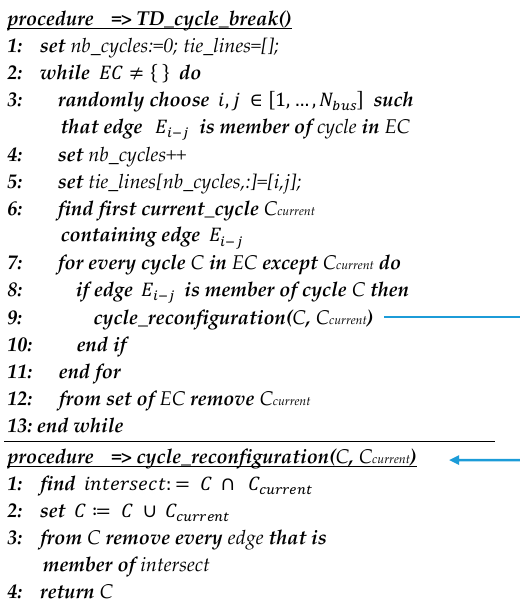
Algorithm 3. Pseudocode for BU cycle break